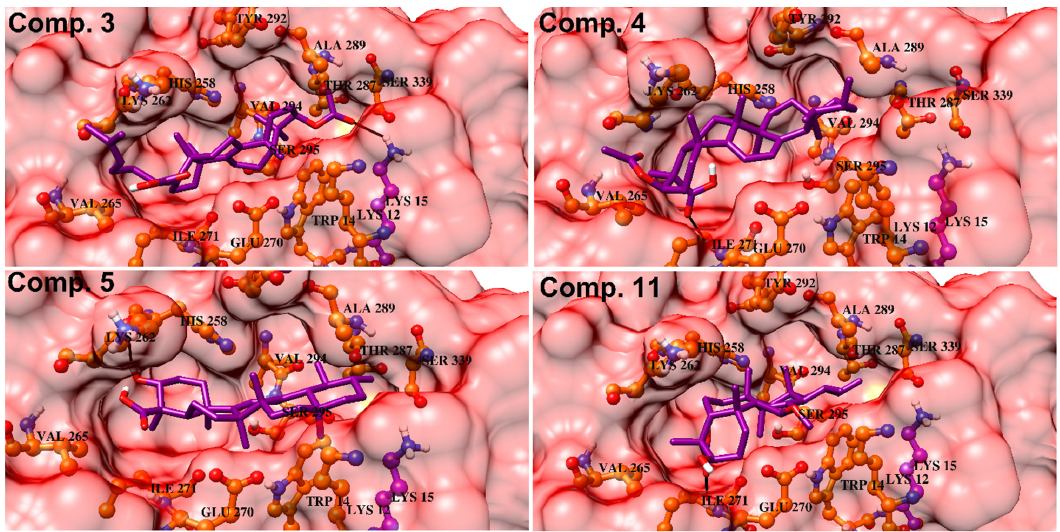
Figure 8. Docked orientations of compounds 3 – 5 and 11 are shown in the Cavity 1. The compounds are shown in purple sticks, hydrogen bonds are presented in black lines.